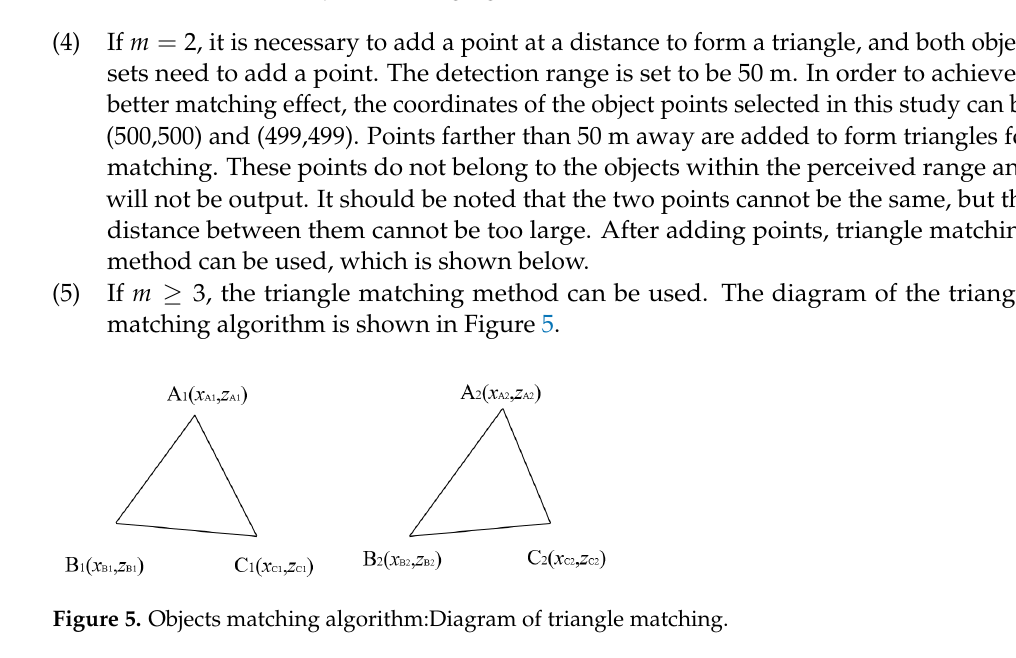
Figure 4. Scheme flow of objects matching algorithm.